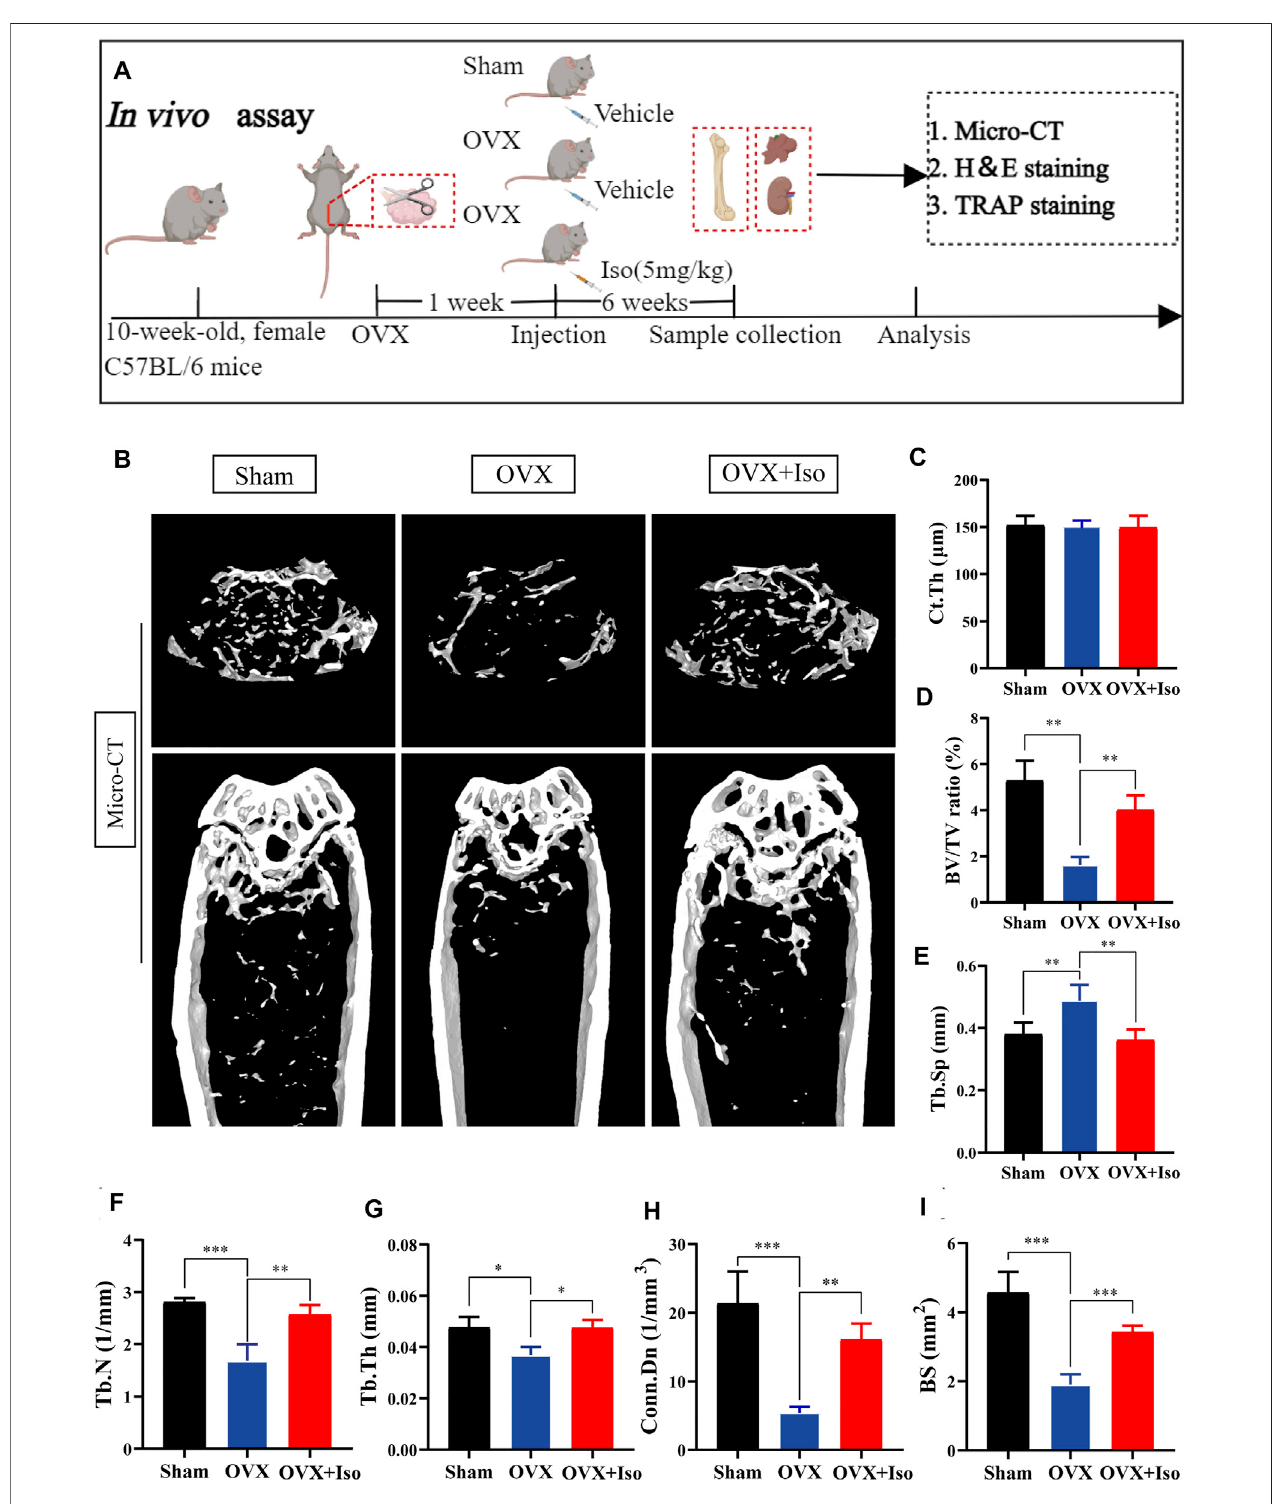
FIGURE 6 | Iso attenuates bone loss in ovariectomized (OVX) mice. (A) Establishment of an osteoporosis model of OVX mice and an experimental design to evaluatetheef fi cacyofIso (B – I) Quantitativeanalysisofbone-relatedparameters,includingCt.Th,BV/TVTb.Sp,Tb.N,Tb.Th,Conn.Dn,andBS( n =5).Theabovedata areexpressedasthemean±SD;* p < 0.05,** p < 0.01,and*** p < 0.001.Iso:Isoliensinine;Vehicle,1%DMSOinPBS;TRAP,tartrate-resistantacidphosphatase.Ct.Th, cortical bone thickness; BV/TV, bone volume per tissue volume; Tb. Sp, trabecular spacing; Tb.N, trabecular number; Tb.Th, trabecular thickness; Conn. Dn, connectivity density; BS, bone